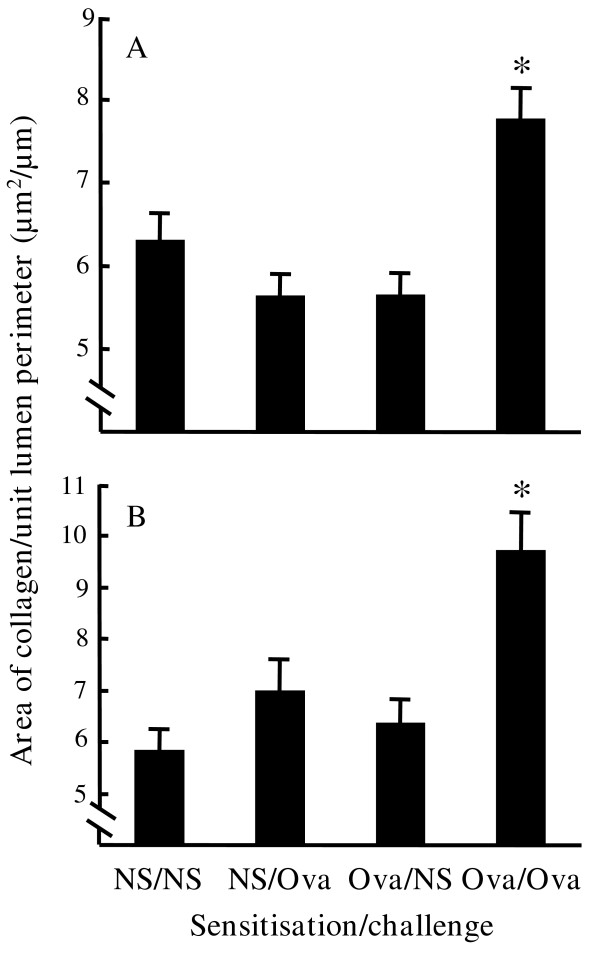
The effect of different sensitisation/challenge combinations on sub-epithelial collagen deposition. The area of sub-epithelial collagen/unit lumen perimeter was quantitated in mouse airways using image analysis of MSB stained sections. (A) Mean values for all suitable airways in each experimental group were compared. The numbers of mice/total airways analysed per group were: saline sensitised/saline challenged (NS/NS) 8/89, saline sensitised/ovalbumin challenged (NS/Ova) 9/95, ovalbumin sensitised/saline challenged (Ova/NS) 7/88 and ovalbumin sensitised/ovalbumin challenged (Ova/Ova) 11/147. (B) Mean values for all suitable larger (perimeter>1000 μm) airways in the same mice were also compared. The numbers of airways analysed were NS/NS 48, NS/Ova 30, Ova/NS 22 and Ova/Ova 39. * p < 0.01 compared with the mean of the controls.